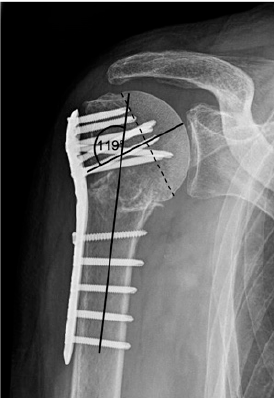
Figure 6. Complication Type 1. Middle: measurement of varus displacement on an a.p. radiograph of a right shoulder after angular stable plate osteosynthesis. The varus displacement is 16° relative to the anatomic CCD angle of 135°. No screw cutout results.